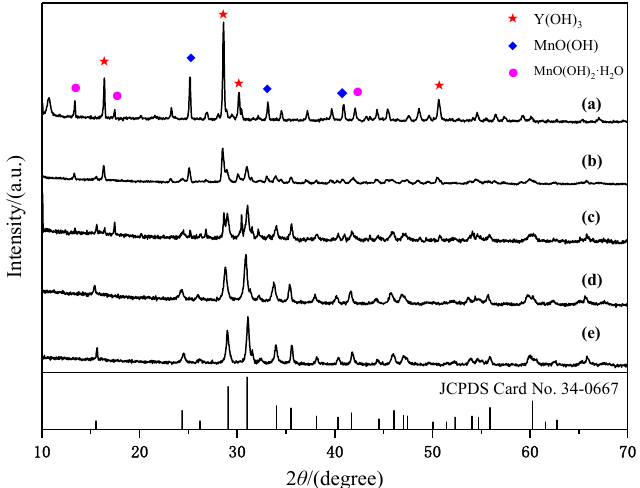
Figure 6. XRD patterns of samples synthesized at 180 °C for different hydrothermal times: ( a ) 6 h; ( b ) 12 h; ( c ) 18 h; ( d ) 24 h; ( e ) 48 h.